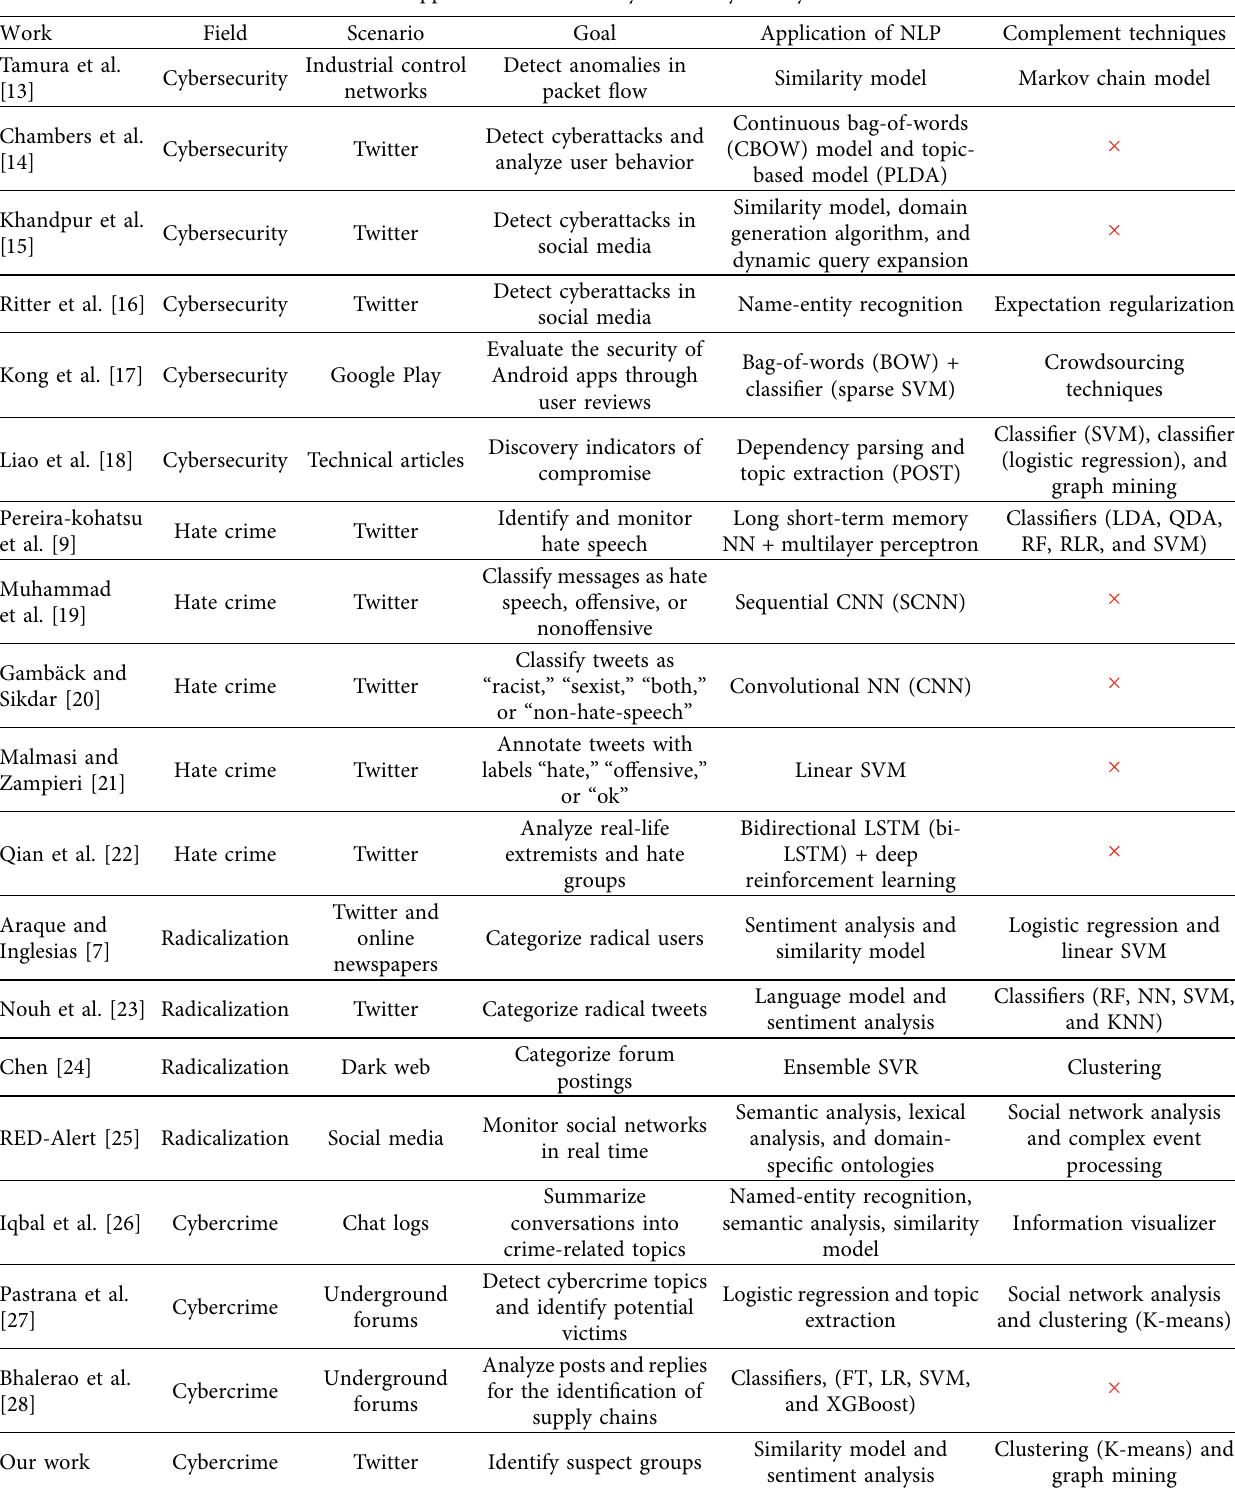
Table 1: Application of NLP in cybersecurity and cyber